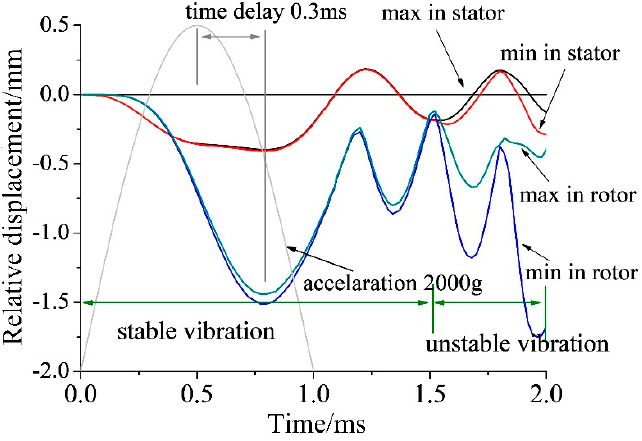
Figure 6. Simulated displacement—time curves of a rotor and a stator.